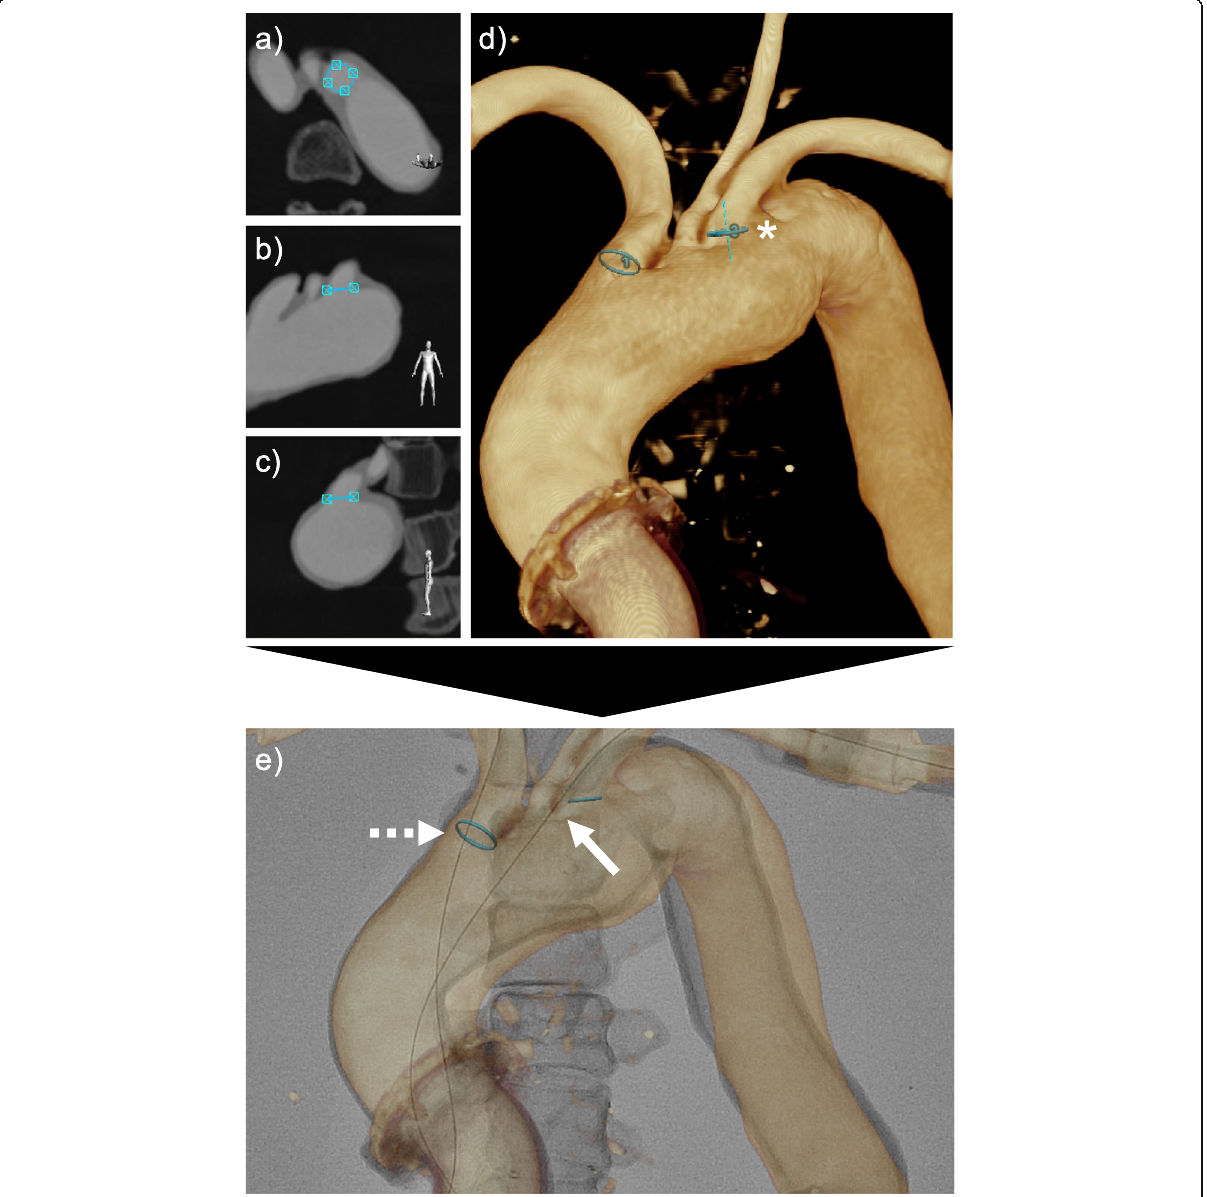
Fig. 2 Exemplary placement of circular markers at vessel orifices and accuracy assessment via cannulation of those orifices with a guidewire. A circular marker was carefully adjusted to the anatomy of the left subclavian artery ’ s orifice using multiplanar reconstructions of the cross-sectional imaging data, in this case, a CTA ( a – c ). Each plane ’ s orientation is demonstrated by the human model in the bottom right corner of each image. d Correct placement of the marker (*) was verified in the vessel ’ s virtual 3D model, which was reconstructed from the original CTA data. For demonstration purposes, another marker was placed in the brachiocephalic trunk. e Subsequently, image fusion was performed, and each orifice was cannulated with a soft guidewire. If the wire went through the circular marker (brachiocephalic trunk; dashed arrow), the marker position was marked as accurate, and if the wire missed the marker (left subclavian artery; straight arrow), the position was dismissed as